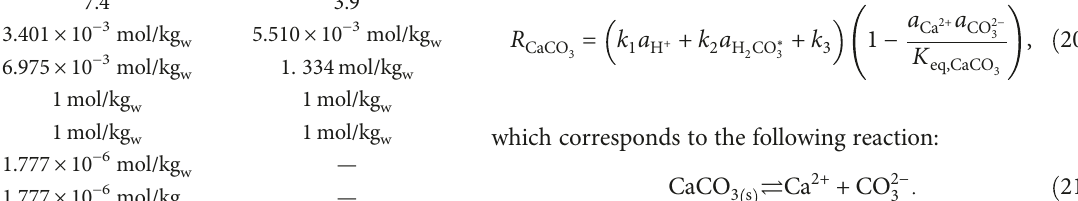
Figure 13: Normalized permeability versus normalized porosity at di ff erent Pe and Da numbers when a single fracture is surrounded only by a single reactive mineral and no nonreactive mineral exists in the rock Table 1: Concentrations used for the initial and inlet solutions. Parameter